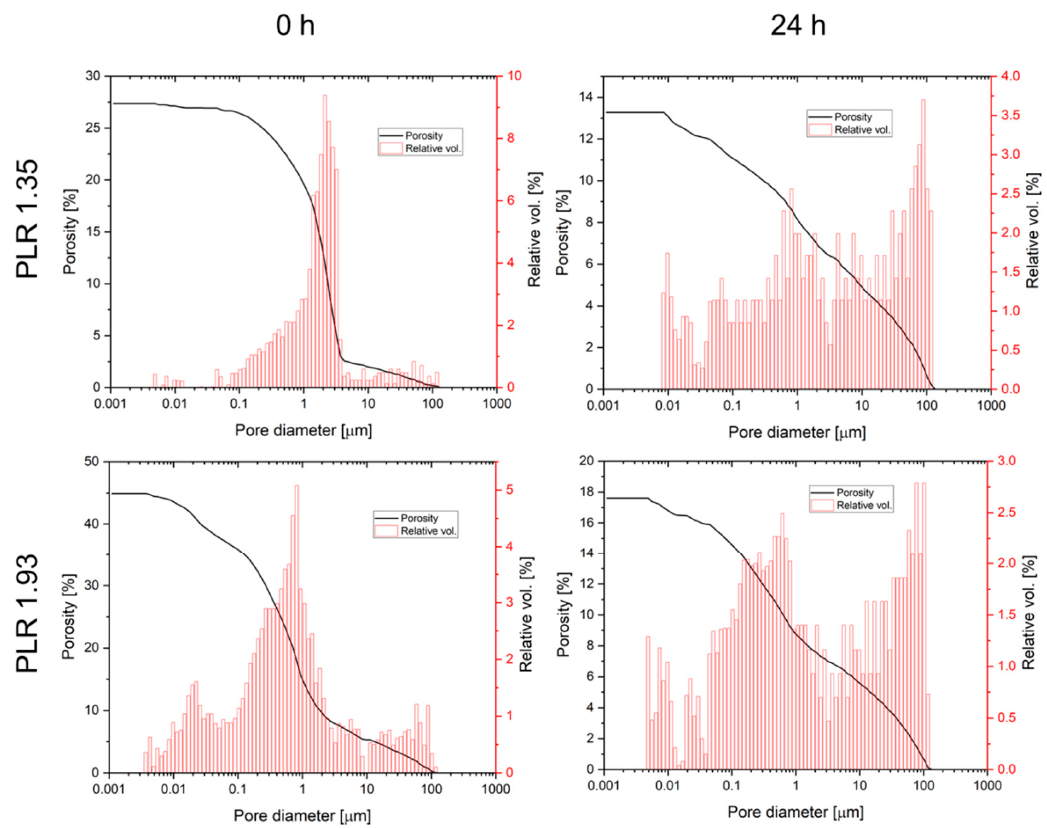
Figure 5. Porosity and pore size distribution of CaMgPO 4 cement pastes immediately after preparation and after 24 h ageing at 37 °C. Samples were hardened in 3.5 M (NH 4 ) 2 HPO 4 solution for 24 h prior to measurement.